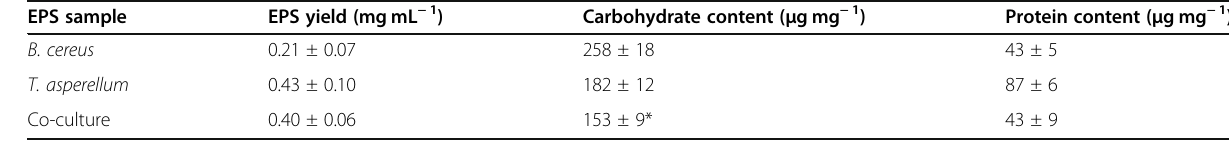
Table 1 The characteristics of EPS from B. cereus , T. asperellum and co-culture